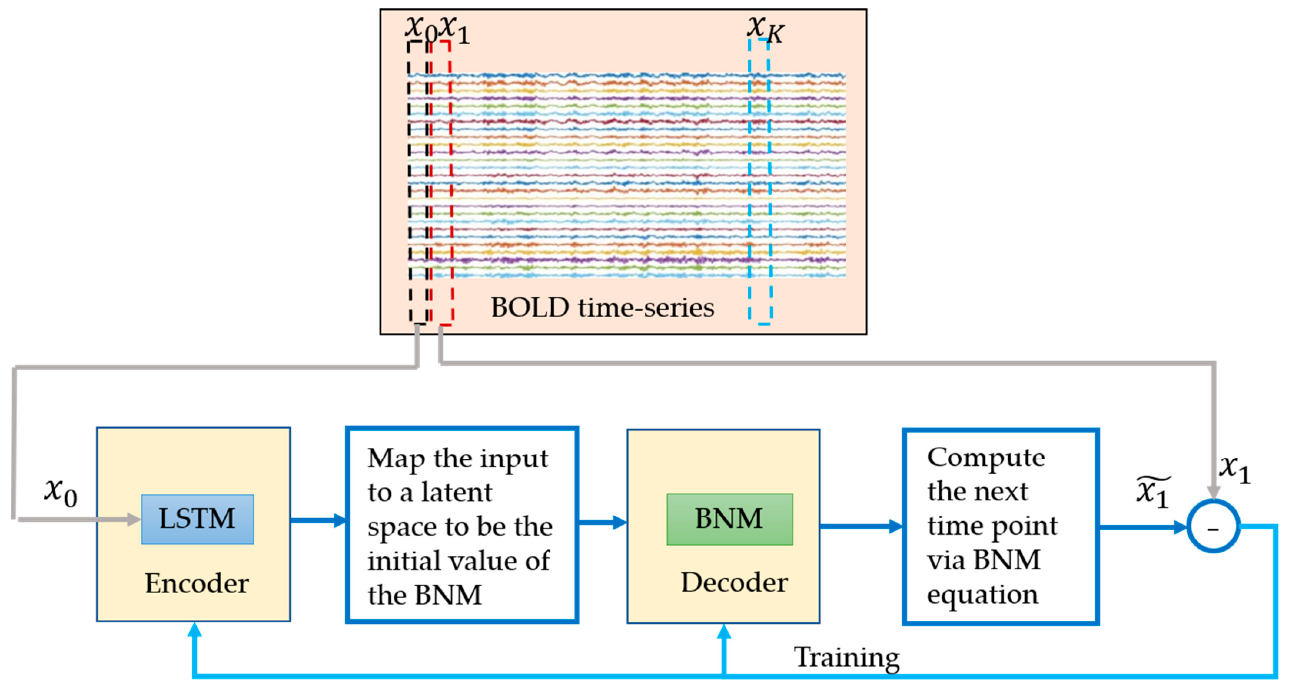
Figure 4. The framework of brain network sequence autoencoder. The measurements at each time points are passed into the LSTM one-by-one, LSTM map the input into a latent space which is a smaller space constrained by the BNM. Then, this latent variable is input into the BNM as an initial condition, and the measurement at next time point is estimated by BNM forward equations. The system is trained by mismatch between the actual measurement and estimated measurement at the next time point [81,82].